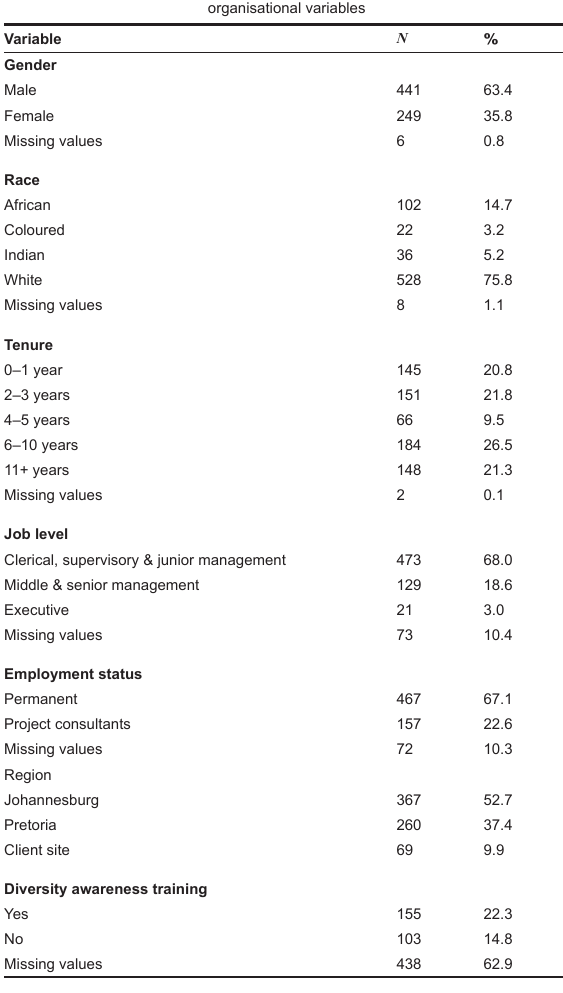
Table 3 Distribution of participants according to biographical and organisational